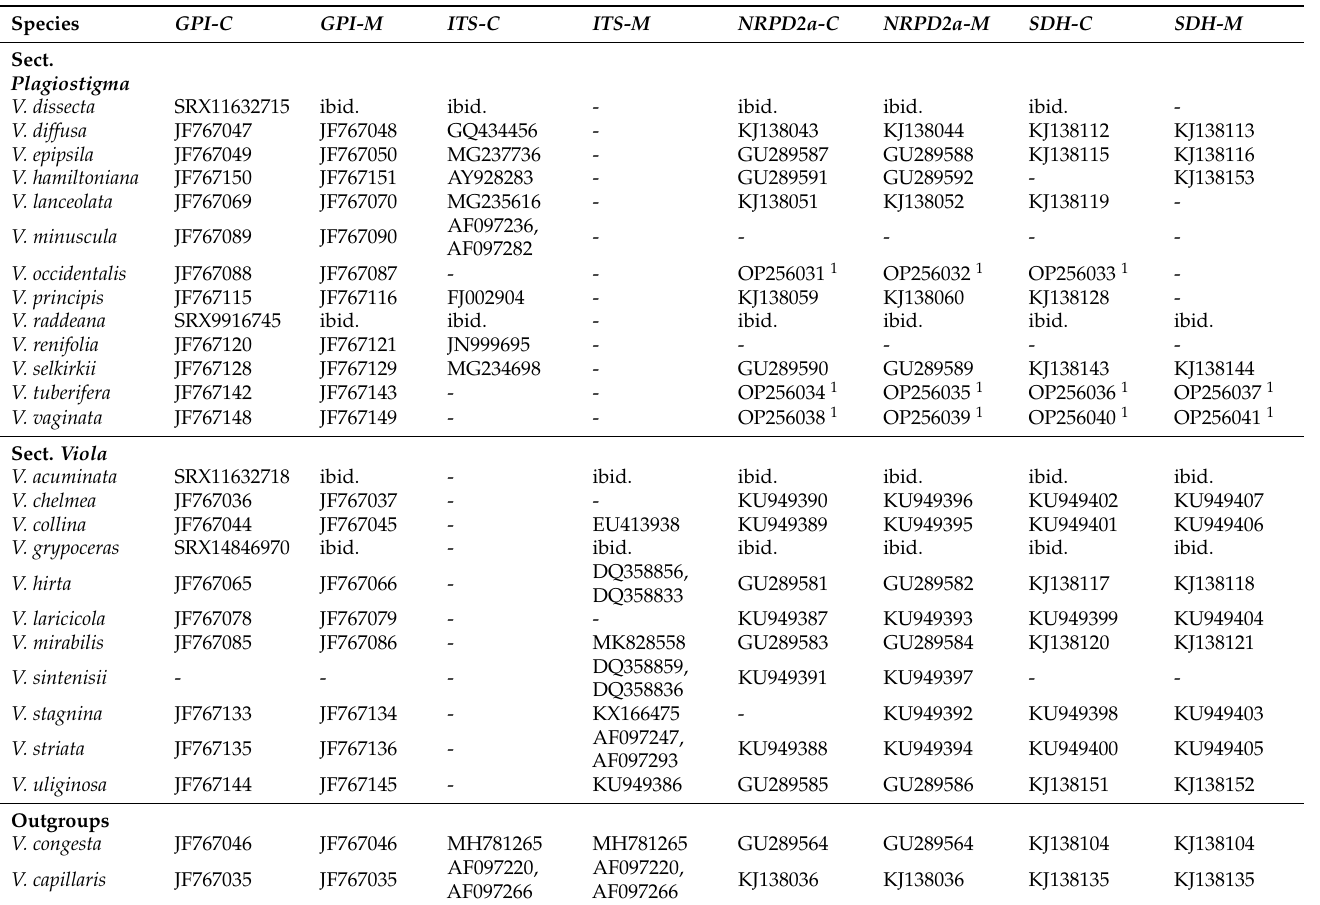
Table 7. Taxa and GenBank sequence IDs for the combined phylogenetic analysis of sect. Plagiostigma and sect. Viola (Figures 27 and 33). A dash indicates missing data. “ibid.” is used for taxa with genomic data whose loci have the same GenBank ID (given under GPI-C ). Taxon names have been edited to correspond to the nomenclature used herein. Metadata for each sequence are available at